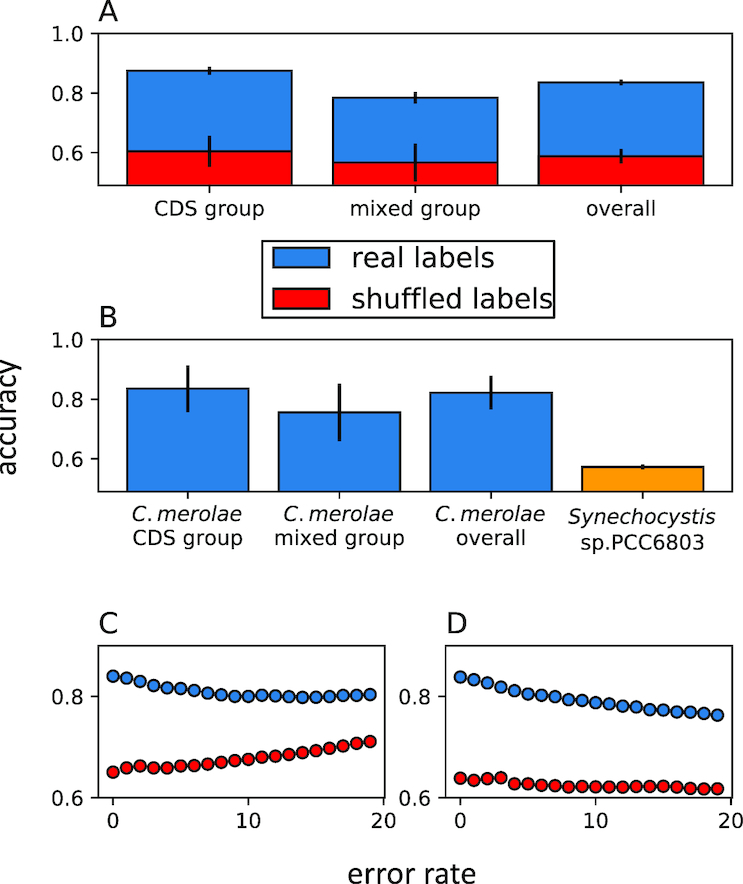
Model performance evaluation. (A) Accuracy scores of the random-forest classifier on real labels and random labels (see legend). \documentclass[12pt]{minimal}
\usepackage{amsmath}
\usepackage{wasysym} 
\usepackage{amsfonts} 
\usepackage{amssymb} 
\usepackage{amsbsy}
\usepackage{upgreek}
\usepackage{mathrsfs}
\setlength{\oddsidemargin}{-69pt}
\begin{document}
}{}${N_{{\rm CDS}}}$\end{document} = 121, \documentclass[12pt]{minimal}
\usepackage{amsmath}
\usepackage{wasysym} 
\usepackage{amsfonts} 
\usepackage{amssymb} 
\usepackage{amsbsy}
\usepackage{upgreek}
\usepackage{mathrsfs}
\setlength{\oddsidemargin}{-69pt}
\begin{document}
}{}${N_{{\rm mixed}}}$\end{document} = 92. (B) Prediction accuracies on the red alga Cyanidioschyzon merolae when discarded from the initial dataset, and on the cyanobacteria Synechocystis sp. PCC6803 labels derived from (12). The bars represent coding-sequence gene pairs (‘CDS group’), a mixture of tRNA, rRNA or coding sequence gene pairs (‘mixed group’) and the weighted mean of the two groups (‘overall’). Synechocystis sp. PCC6803 encompasses only CDS gene pairs. The bars show mean ± STD. (C) Type I (false-positive mistake) error test. (D) type II (false-negative mistake) error test. An overall of 19 errors were introduced into the labels and for each error rate the prediction pipeline was repeated. The same analysis was carried out on random labels. All accuracy scores were calculated based on the average accuracies of ten bootstrap trained samples.